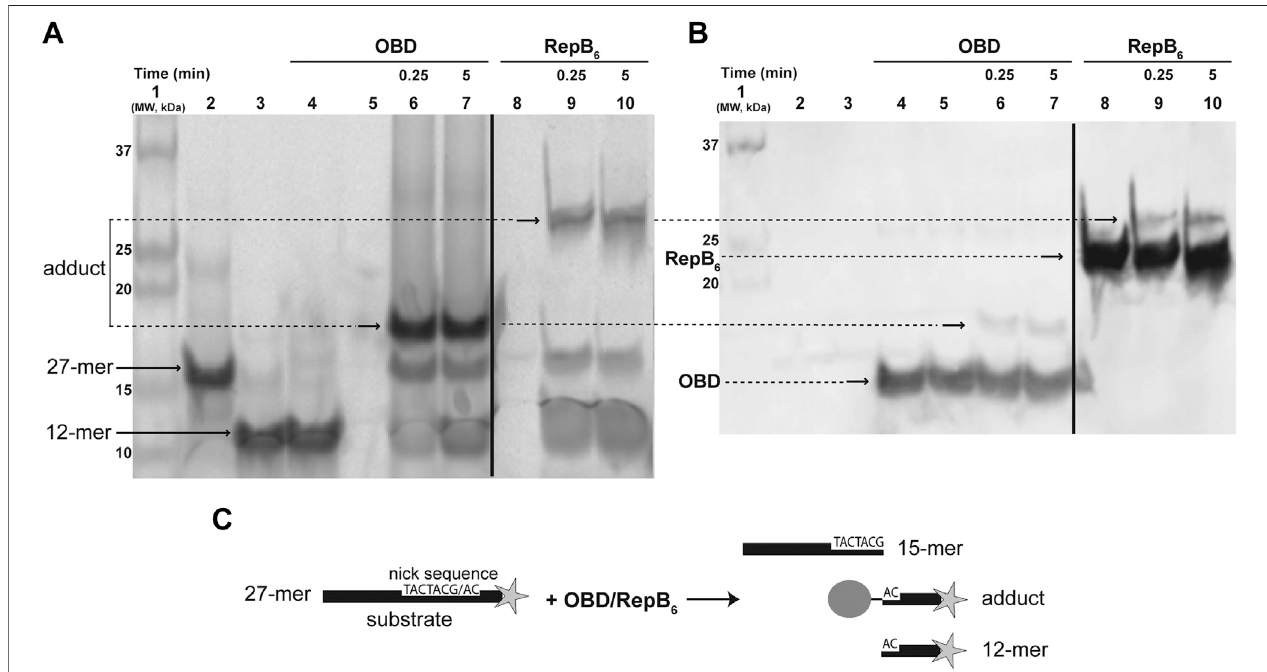
FIGURE 1 | Detection of the RepB-DNA covalent complex. (A) Direct visualization of the fl uorescent DNA species that arise from the endonuclease activity of RepB 6 and OBD on the ssDNA 27-mer oligo substrate. A prestained and chemiluminescent protein ladder was loaded in lane 1. Lanes 2 and 3 show the migration of fl uorescent 27-mer substrate and chemically-synthesized 12-mer oligo, respectively. In lane 4, a mixture of OBD and chemically-synthesized fl uorescent 12-mer oligo (which is not a substrate of the protein) was loaded. OBD (lanes 6 and 7) and RepB 6 (lanes 9 and 10) were incubated for the indicated times with the 27-mer